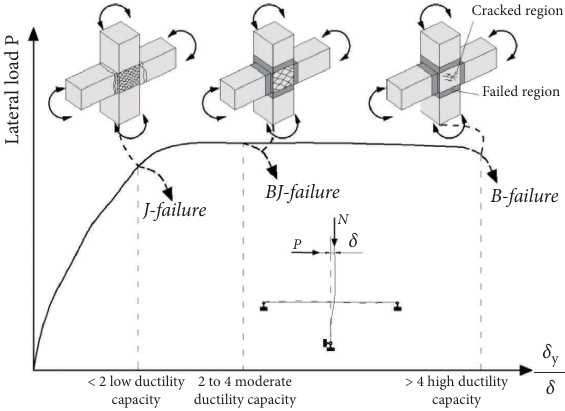
Figure 2: Te three joint failure